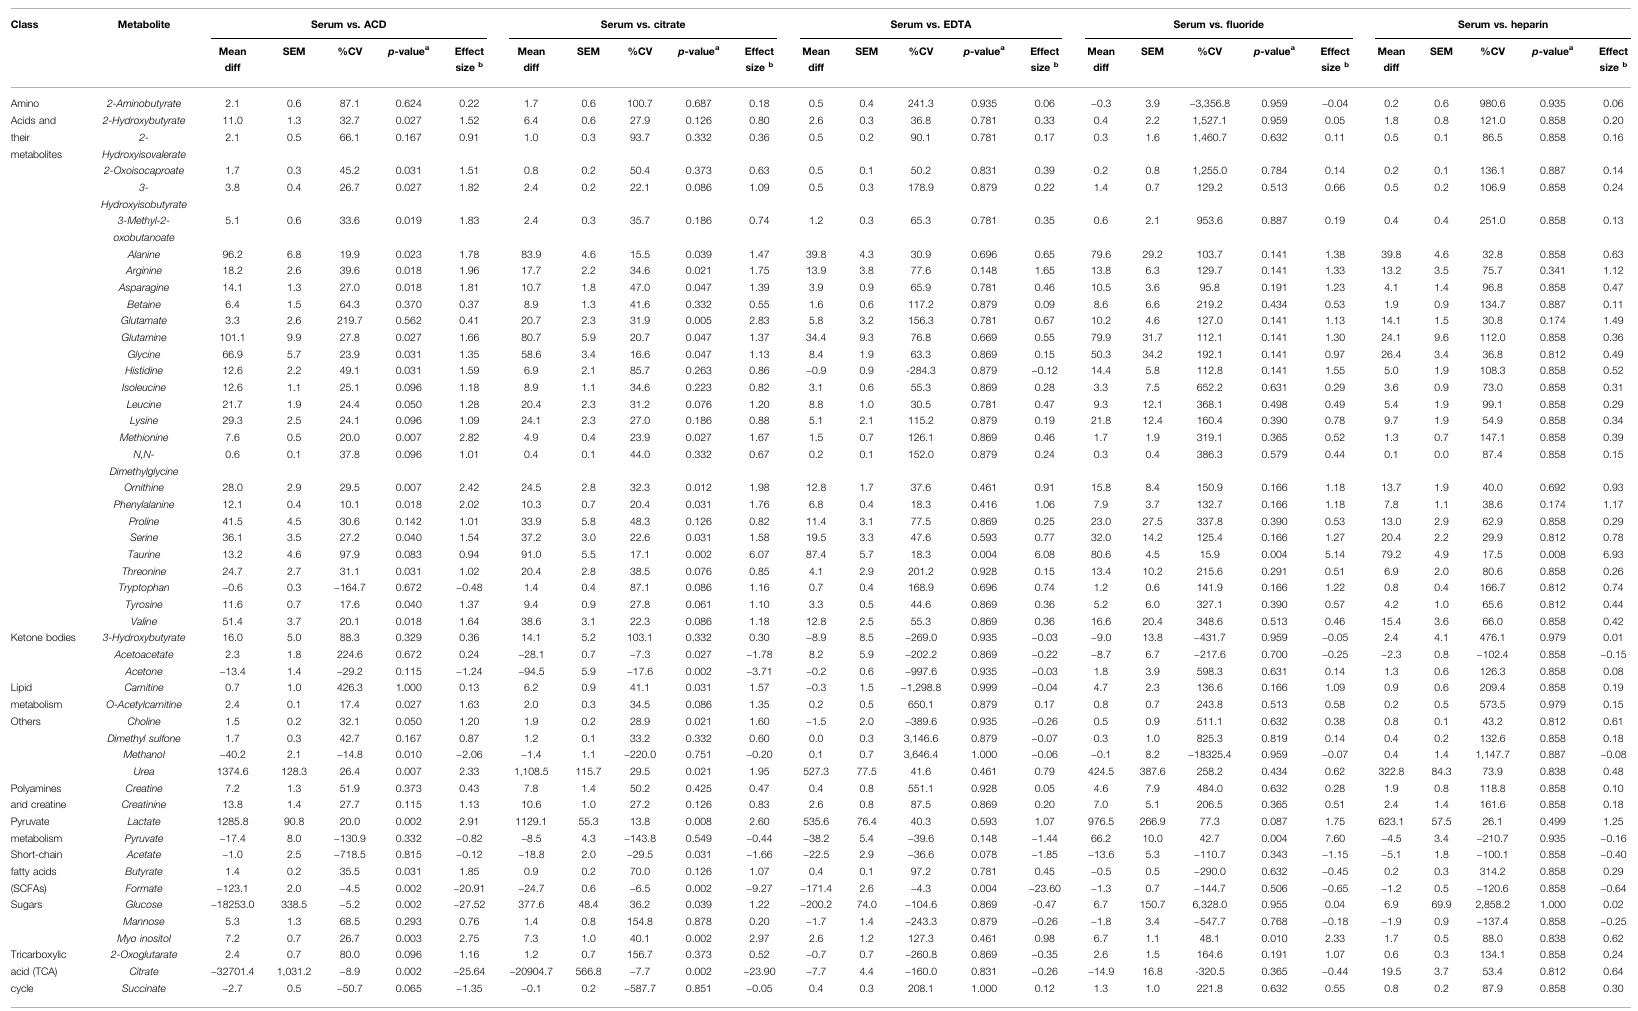
TABLE2| ComparisonofSerumVs.Plasma.Thetableshowsthemeandifference,standarderrorofthemean(SEM),CV%, p -value,andeffectsizedifferenceofmetaboliteconcentrations(µM)inserum(reference)Vs.each respective plasma